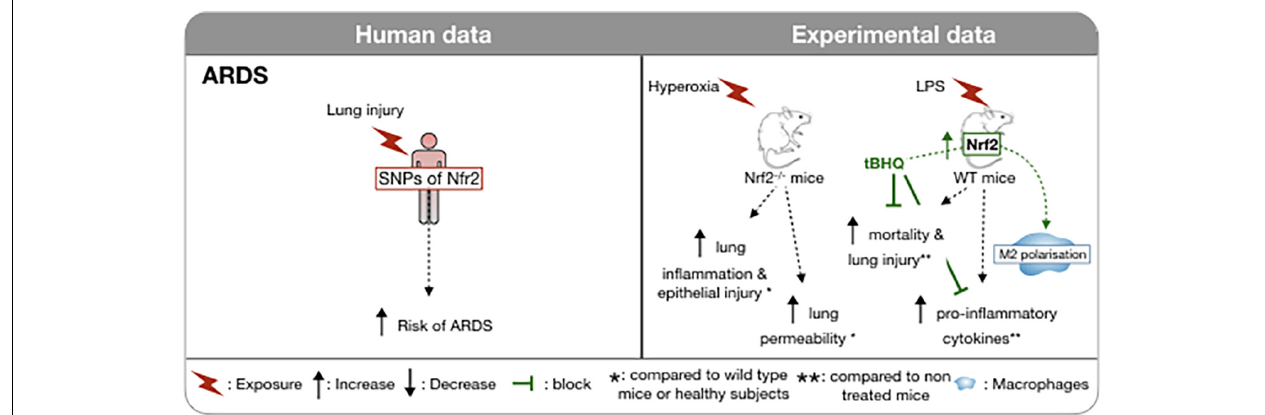
FIGURE 1 | Involvement of Nrf2 in ARDS in humans and in vivo models. In humans, the risk of developing an ARDS during severe trauma is associated with the possession of a functional promoter that has affected the binding affinity to a promoter site upstream of the Nrf2 gene. Induction of hyperoxia-induced ARDS in NRf2-deficient mice is associated with increased lung inflammation and capillary permeability. Conversely, in a LPS induced ARDS model, induction of Nrf2 is associated with a decrease in mortality and inflammation, notably via the M2 polarization of macrophages. ↑ , Increase; ↓ , Decrease; block; *, compared to wild type mice or healthy subjects; **, compared to un- treated mice; , macrophages; WT, wild